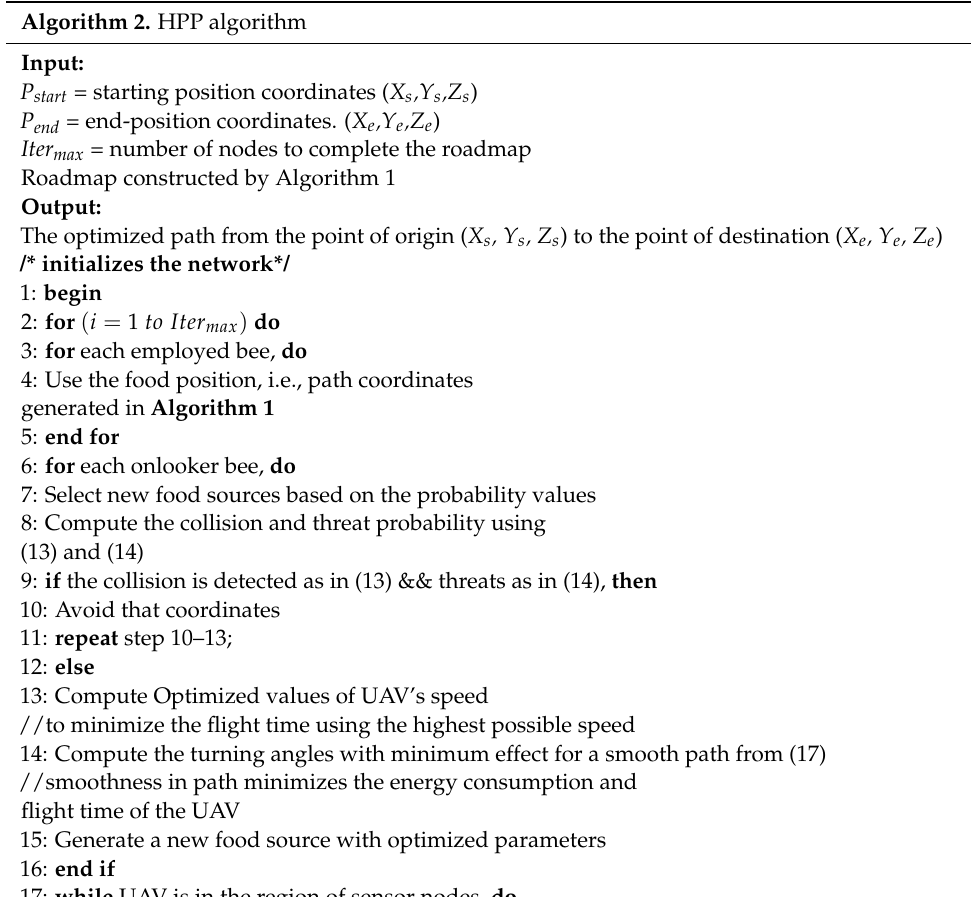
Algorithm 2. HPP